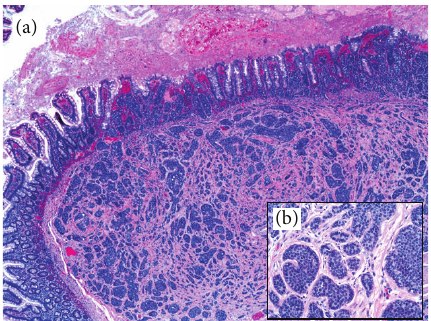
Figure 5: (a) Low power view of the incidental carcinoid found within the Meckel’s diverticulum. The tumor was found to be 0.6cm in its greatest dimension and showed invasion of the subserosa without involvement of the visceral peritoneum. Proximal and distal margins were uninvolved. Pathological staining was consistent with a pT2N0Mx carcinoid tumor. (b) High power view of the carcinoid tumor showing its acinar nests of uniform-appearing